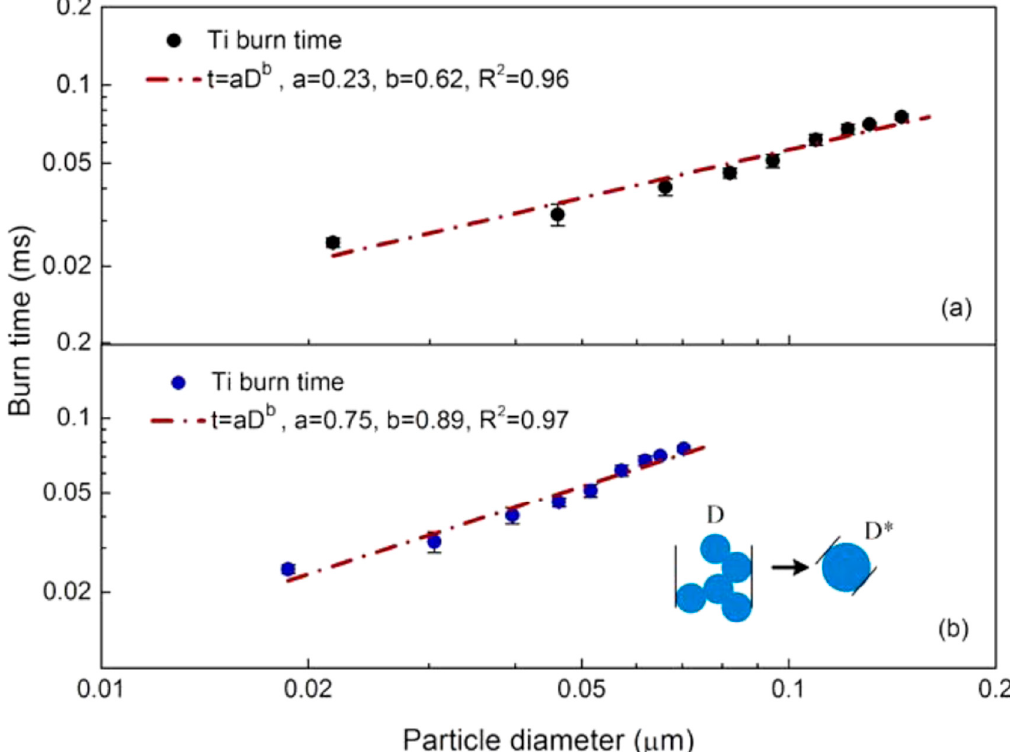
Figure 10. Ti particles burning time vs. particle size diagrams: ( a ) based on the peak DMA selected particle size, ( b ) based on the TEM measured diameter after sintering. Reprinted from [30] with permission from J. Phys. Chem. A. Copyright 2015 American Chemical Society.